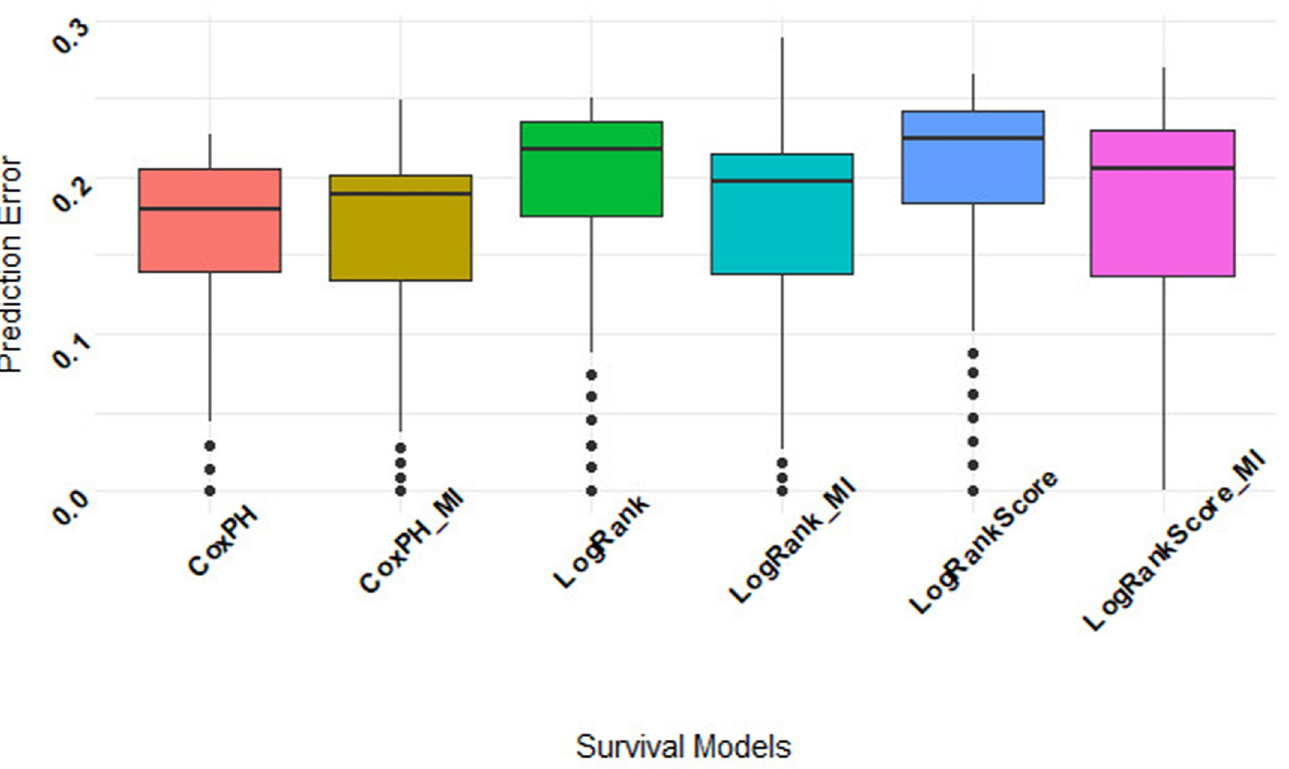
Fig 8. RSF with (log-rank and log-rank score) and Cox PH boxplot prediction error using 20% testing set together with the complete case dataset and the imputed data.